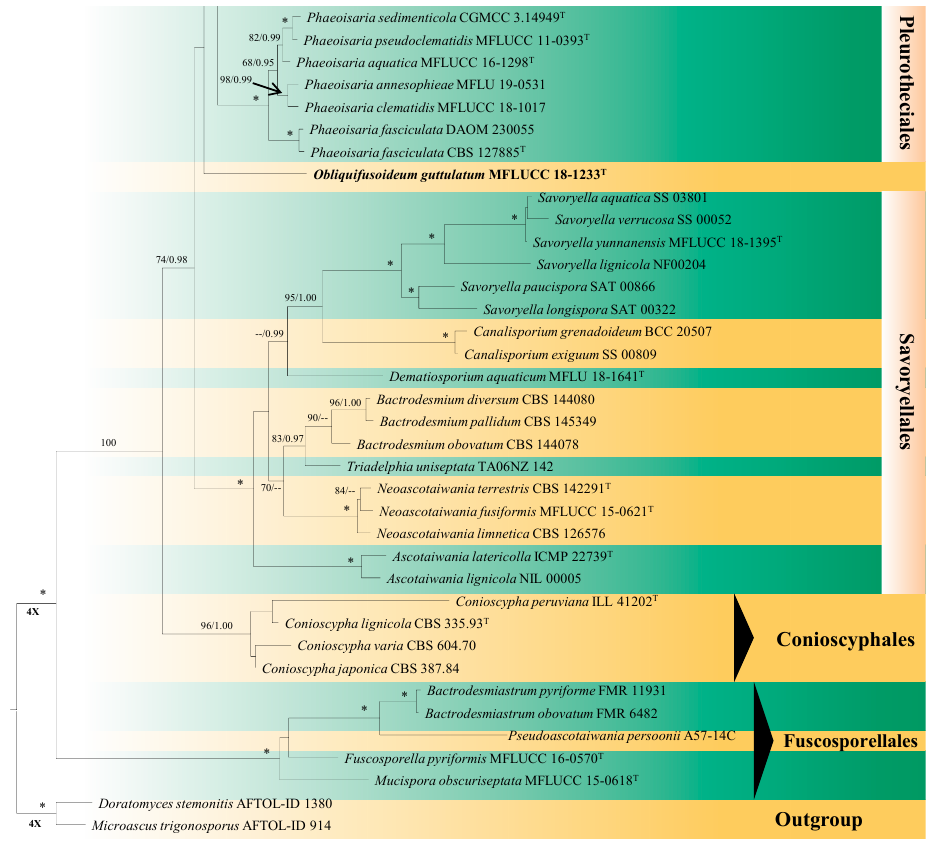
Figure 1 . RAxML tree of Savoryellomycetidae with four orders, Conioscyphales, Fuscosporellales, Pleurotheciales and Savoryellales. The multi-locus tree is generated from combined LSU, SSU, ITS and rpb2 sequence data. Bootstrap support values for maximum likelihood (the first value) equal to or greater than 60% and Bayesian posterior probabilities (the second value) equal to or greater than 0.95 are placed near the branches as ML BS/BI PP. The asterisk “*” represents bootstrap support values with 100% ML BS and 1.00 BI PP. The tree is rooted to Doratomyces stemonitis AFTOL-ID 1380 and Microascus trigonosporus AFTOL-ID 914. The ex-type cultures are indicated using “ T ” after strain numbers and the new species introduced in this study are indicated in bold .